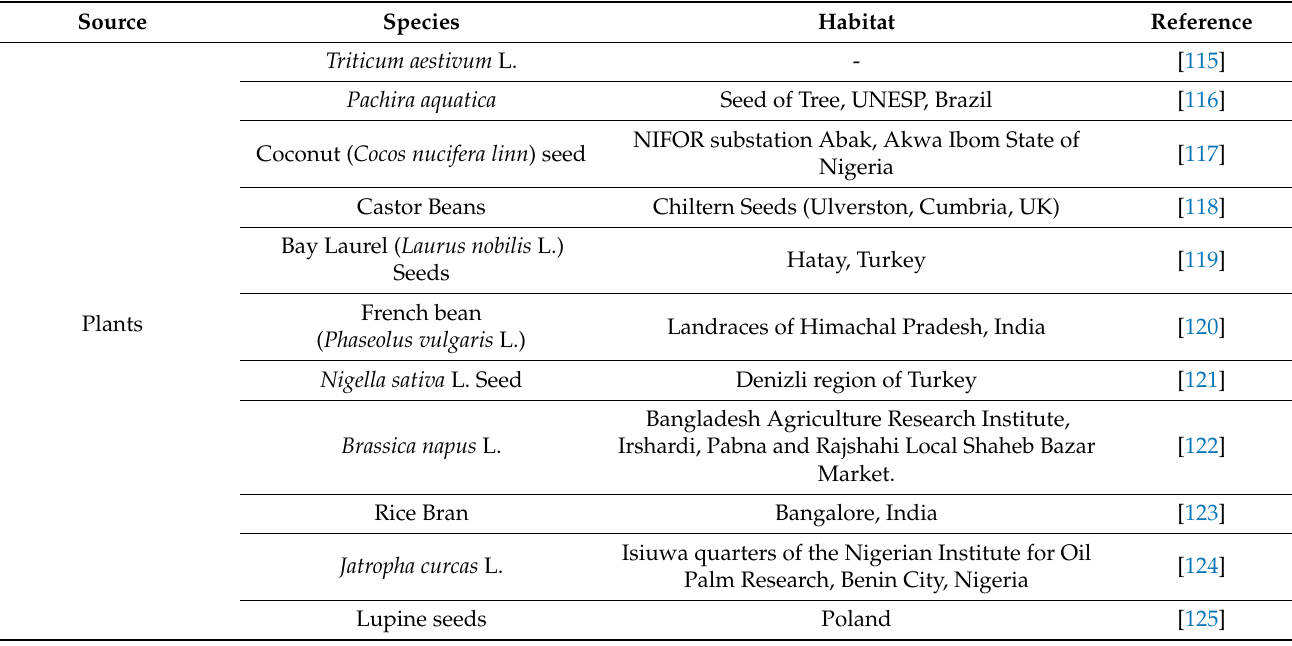
Table 2. Lipase-producing organisms and their